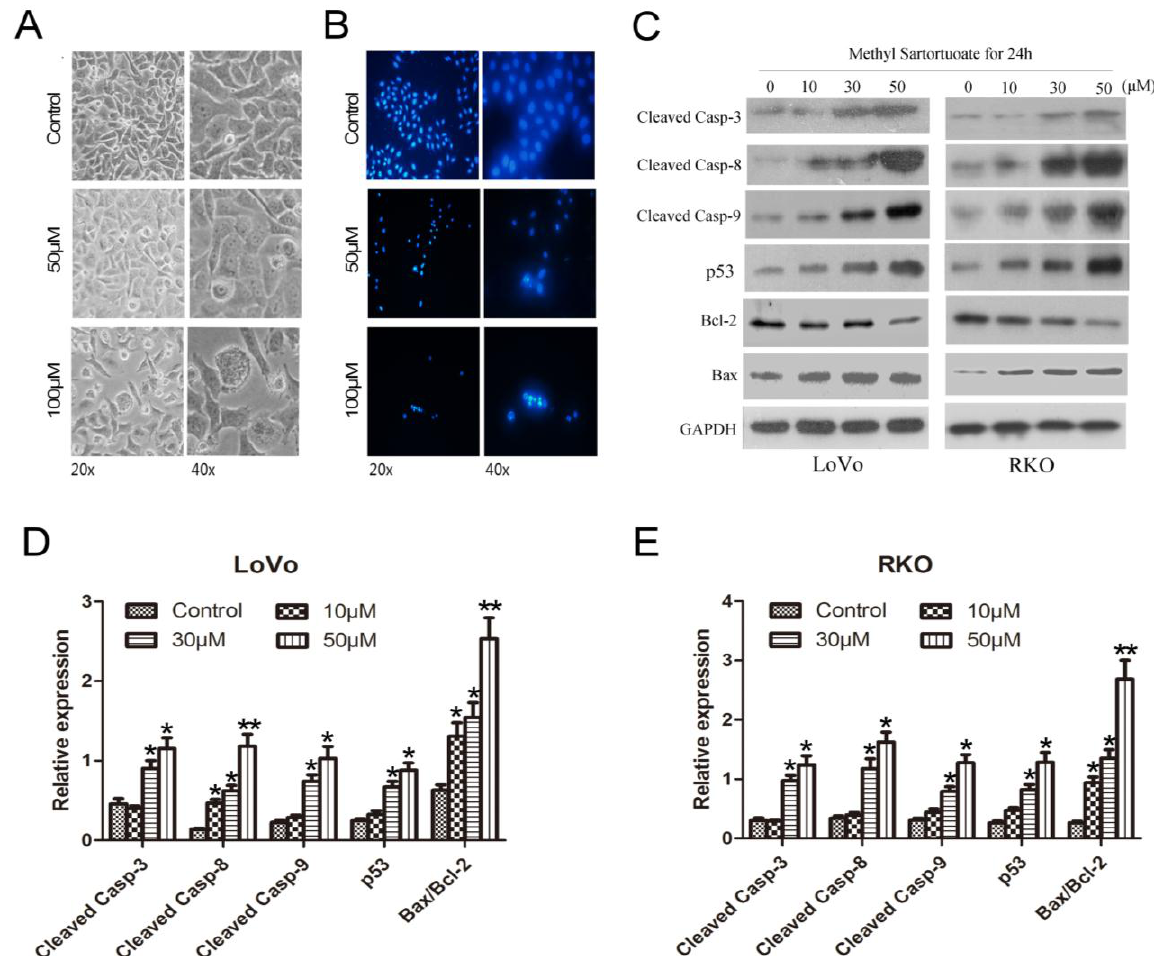
Figure 3. Methyl sartortuoate induces colon cancer cell apoptosis by activated apoptosis-related proteins expression. ( A ) Morphological changes in the